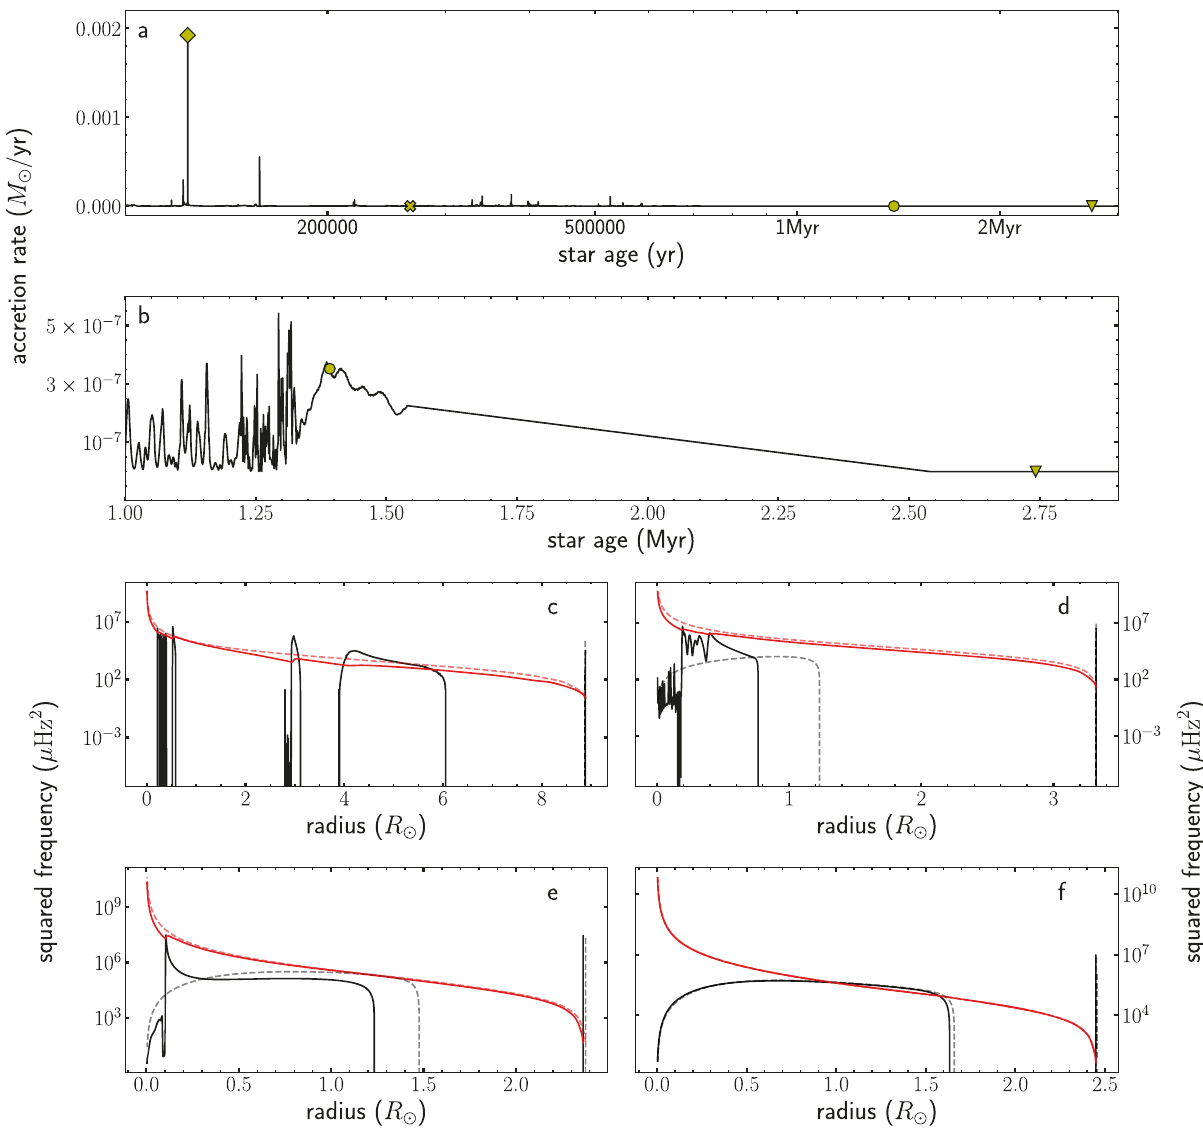
Fig. 2 | Comparison between the asteroseismic structure of the disk-mediated and the classical evolution model at early stages. a Mass accretion history of model #27. b Zoom into the mass accretion history of model #27 towards the end of the accretion phase.Yellow symbols mark speci fi c positions. c – f Squared Brunt- Väisälä frequency(black)and squared Lambfrequencyfor l =1 (red). The solidline corresponds to the disk-mediated model while the dashed line corresponds to a snapshot of the classical pre-main sequence model with the same radius for com- parison. c Themodelduringahighaccretionphase(diamond).Theclassicalmodel